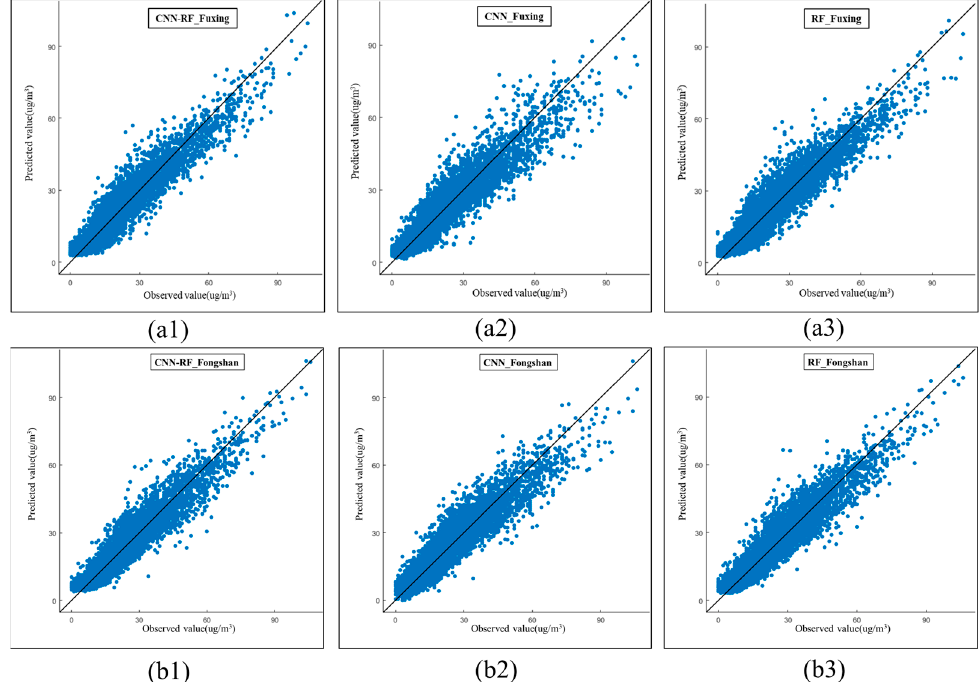
Figure 5. Scatterplots of predictive PM2.5 concentration models. ( a1 ) Prediction scatterplot of CNN– RF model at the Fuxing station. ( a2 ) Prediction scatterplot of CNN method at the Fuxing station. ( a3 ) Prediction scatterplot of RF method at the Fuxing station. ( b1 ) Prediction scatterplot of CNN–RF model at the Fongshan station. (b2 ) Prediction scatterplot of CNN method at the Fongshan station. ( b3 ) Prediction scatterplot of RF method at the Fongshan station.